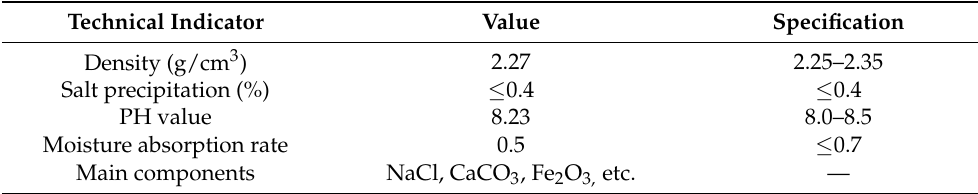
Figure 1. MFL powder. Table 3. Technical indices of MFL.